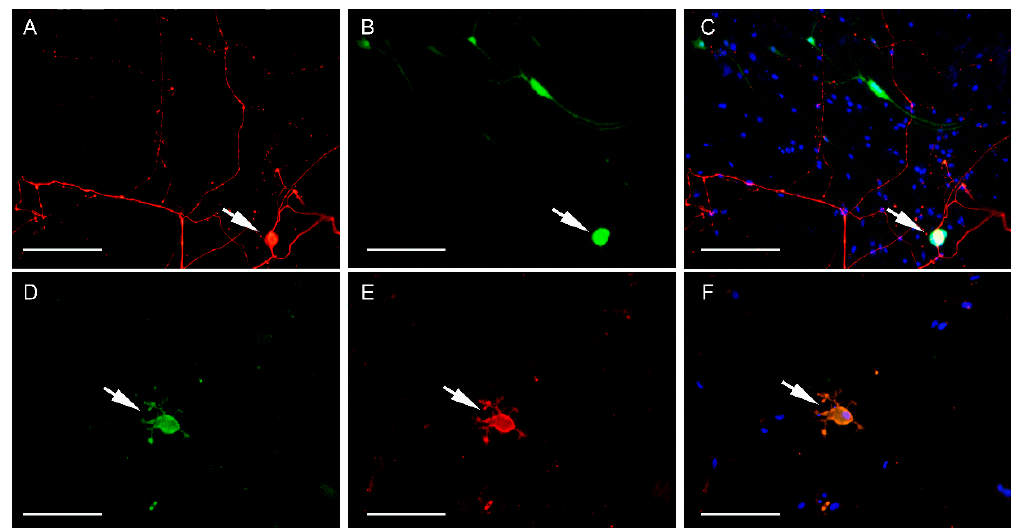
Figure 5. Immunofluorescence images of non-cryo neurons infected with CDV-5804 PeGFP ( A–C ) and CDV R252 ( D–F ) at 6 dpi. A: NF (red) indicates neuron with several branched neurites (arrow). B: eGFP-expression (green) indicating infection by CDV -5804 PeGFP in a neuron (arrow) and several glial cells. C: Merged image of A and B including bisBenzimide nuclear stain (blue) shows expression of eGFP indicating infection with CDV-5804 PeGFP in the cell body of the neuron (arrow) and in the cell bodies and processes of glial cells. D: NF (green) indicating neuron (arrow) with short, branched neurites. E: Red signal (CDV-nucleoprotein) is visible in the cell-body as well as the neurites of a non-cryopreserved neuron (arrow). F: Merged image of D and E including bisBenzimide nuclear stain (blue) indicating a neuron infected with CDV R242 (arrow) with CDV nucleoprotein present in the cell body and neurites. A–C: Bar = 200 µ m. D–F: Bar = 100 µ m. Non-cryo = non-cryopreserved, CDV = canine distemper virus, eGFP = enhanced green fluorescent protein, dpi = days post-infection, NF = neurofilament.